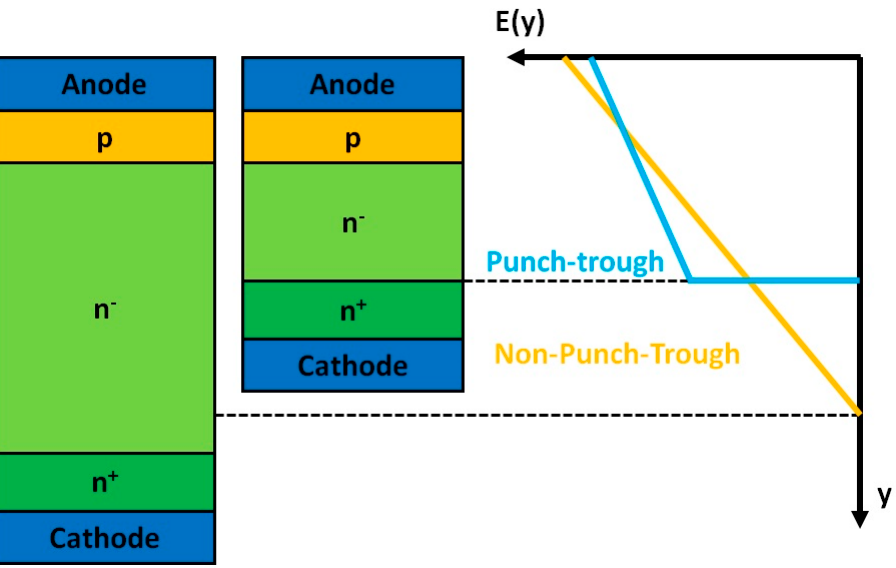
Figure 1. Schematic structure of p-n junctions in non-punch-through case and punch-through case, and the corresponding electric field profiles.